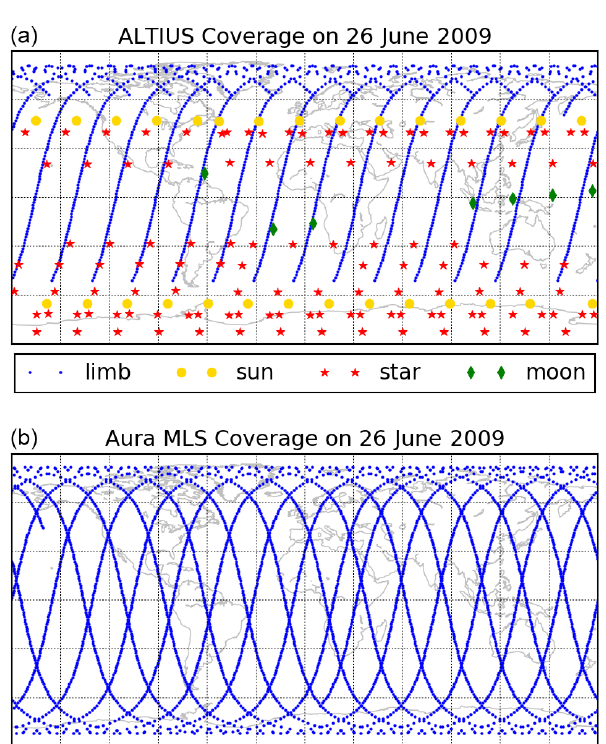
Figure 6. Number of simulated ALTIUS daily profiles for the four observing modes (a) as compared with Aura MLS (b) for the period June–October